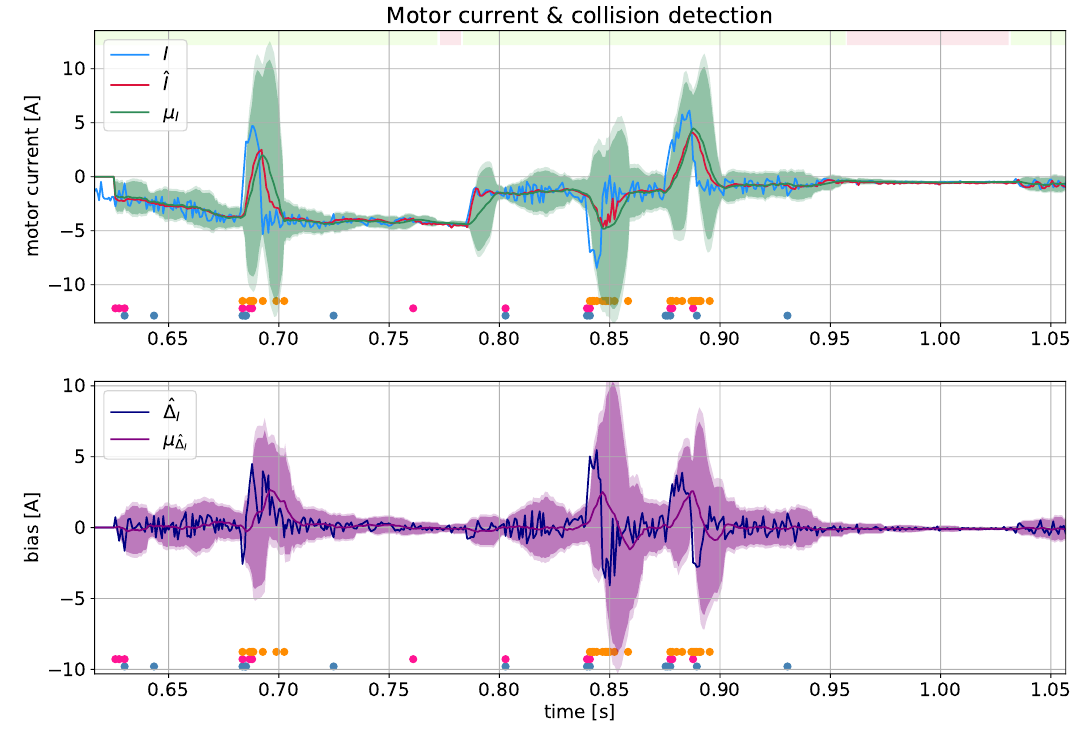
( b ) Measurement and prediction for three collisions. Figure 6. Diagnostic signals using the MC-LSTM(12) model for motor #1, including motor current I (blue line) and its prediction ˆ I (red line), mean motor current µ I (green line along with green confidence area of width γσ I ), and prediction bias, I − ˆ I (dark blue) relative to its mean (purple confidence area around zero of width γσ ˆ ∆ ). The statistical detection I moments ( j ) are denoted by steel blue dots, while the prediction moments ( jj ) are marked as scarlet dots and the optimal threshold detector ( jjj ) is denoted by orange